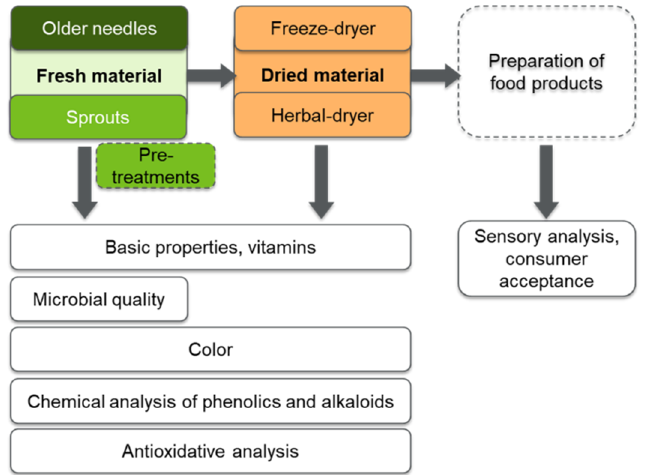
Figure 9. Preparation of the Norway spruce sprouts and needles for different analysis. Pre-treatments: manual removal of matter other than sprouts/needles, e.g., woody stem parts.